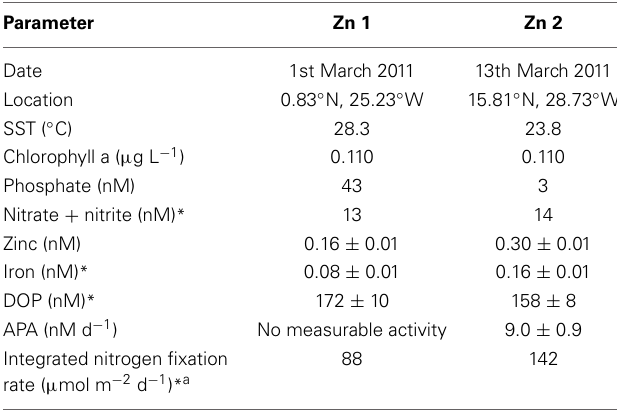
Table 4 | Date, location and initial concentrations ( ± standard deviation) of inorganic and organic nutrients (nM), trace metals (nM) and rates of alkaline phosphatase activity (APA, nM d − 1 ) and nitrogen fixation (nM d − 1 ) at the start (T 0 ) of zinc addition experiments conducted in the eastern subtropical Atlantic during D361 (Spring